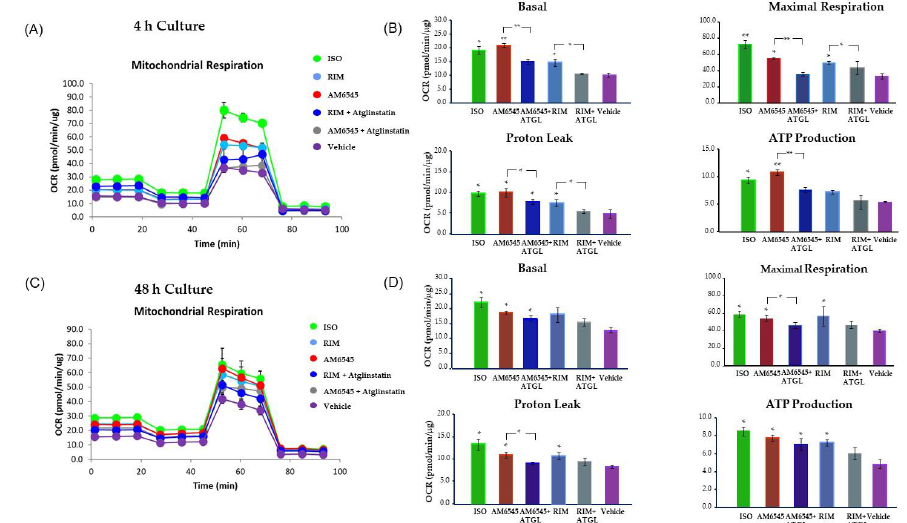
Figure 7. Peripheral cannabinoid receptor 1 (CB1R) antagonist increased oxygen consumption rate (OCR) inhibited by lipolysis blocker. 3T3-L1 adipocytes were treated with AM6545 and rimonabant (RIM) with and without Atglistatin, and isoproterenol (ISO) at 4 and 48 h. OCR was measured in basal conditions or in response to sequential treatment with 2 µM oligomycin, 0.75 µM FFCP (respiratory chain uncoupler), and 1 µM rotenone/antimycin A (inhibitor of respiratory chain complex I and complex III) using the Seahorse XF-24 analyzer. ( A ) Mitochondrial respiration tracing using Seahorse at 4 h after treatment. ( B ) Parameters calculated from the tracing at 4 h after treatment. ( C ) Mitochondrial respiration tracing 48 h after treatment. ( D ) Parameters calculated from the tracing at 48 h after treatment. Data on graphs are presented as the mean ± standard deviation (SD) of 4 independent rounds of the cells; * p < 0.05 vs. control, ** p < 0.01 vs. control. The authors apologize for any inconvenience caused and state that the scientific conclusions are unaffected. The original article has been updated.